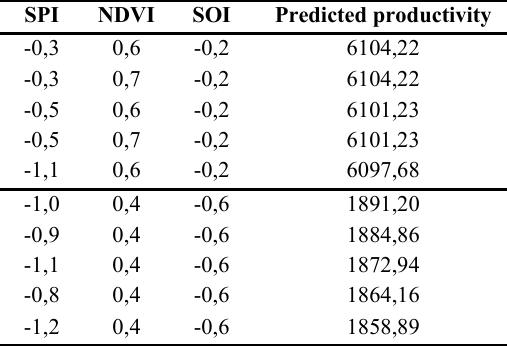
Table 3. Prediction of yerba mate productivity. The top 5 highest and lowest predictions are shown in the table with the respective values for each